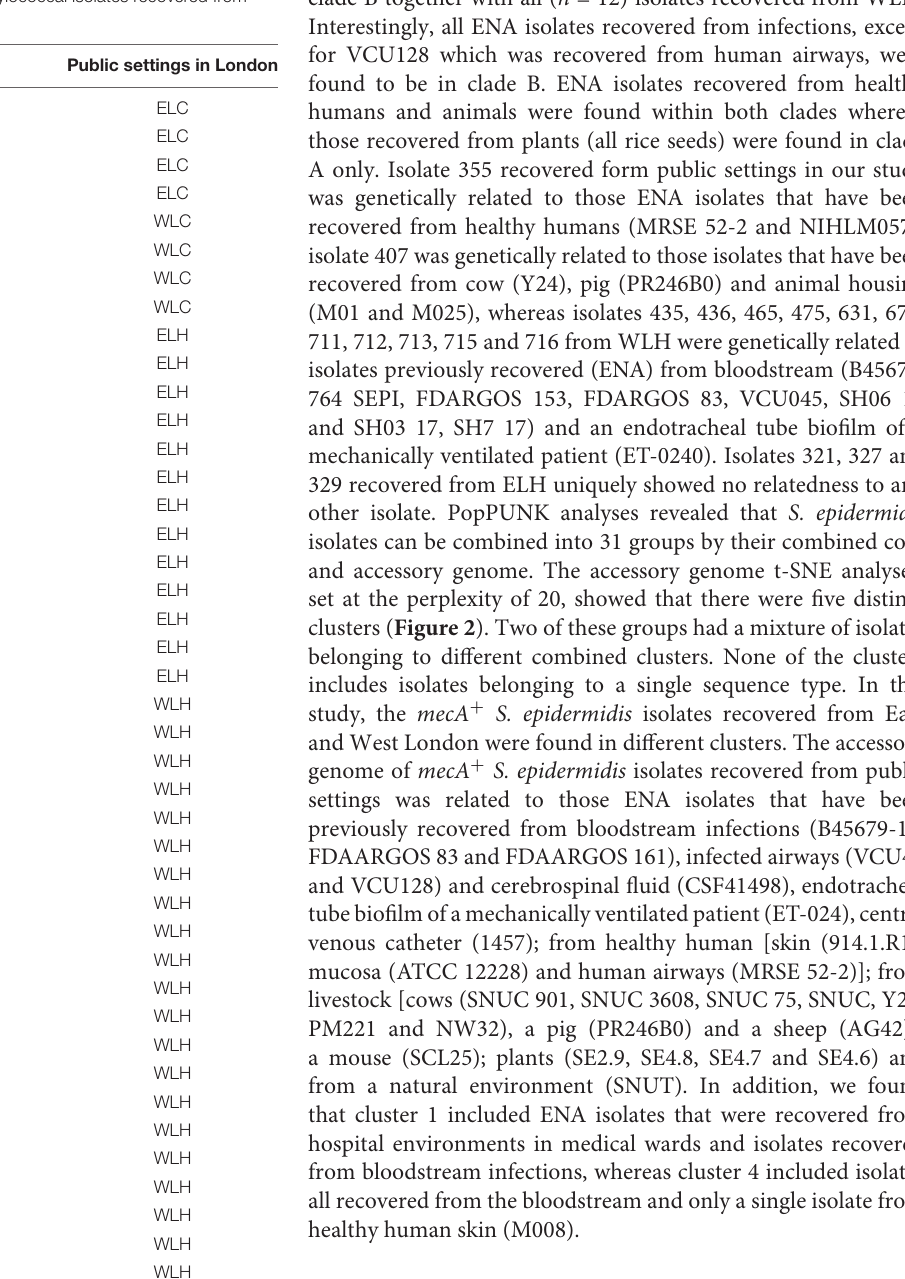
(dog; n = 1), public settings [from the surface area of a building and tropical air sample ( n = 2)], natural